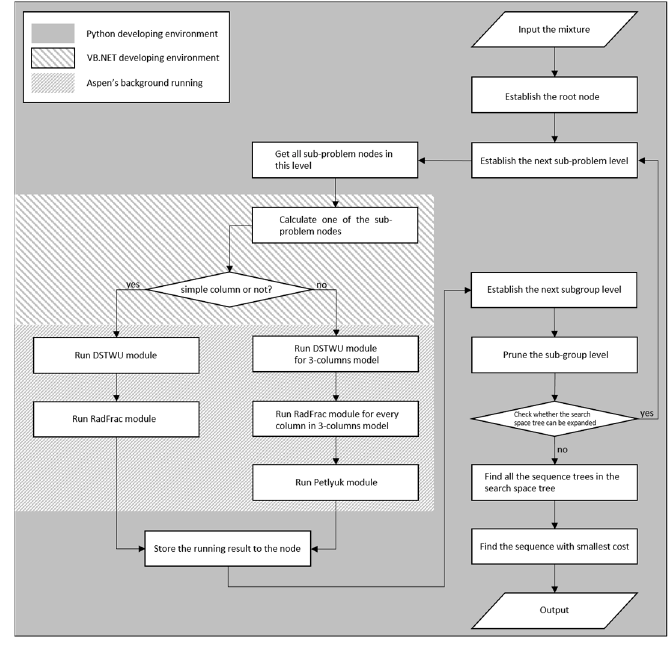
Figure 4. Diagram of framework.